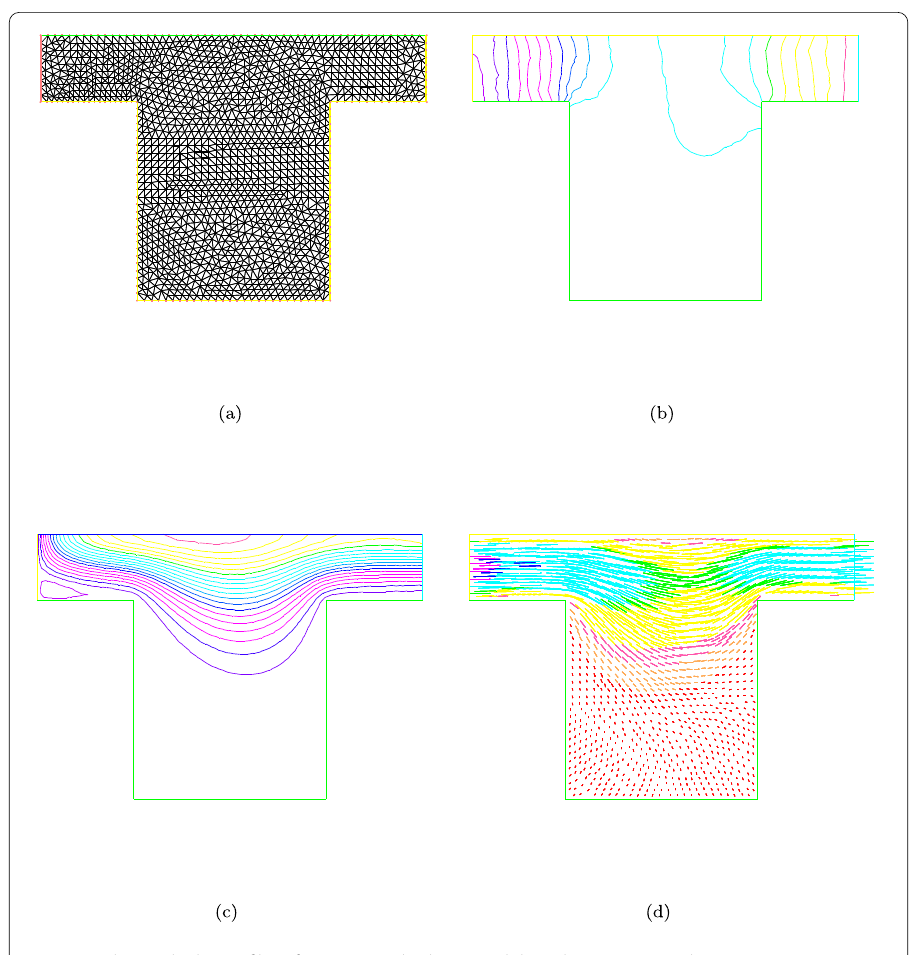
Figure 9 The mesh, the profiles of pressure and velocity, and the velocity vector with NT =